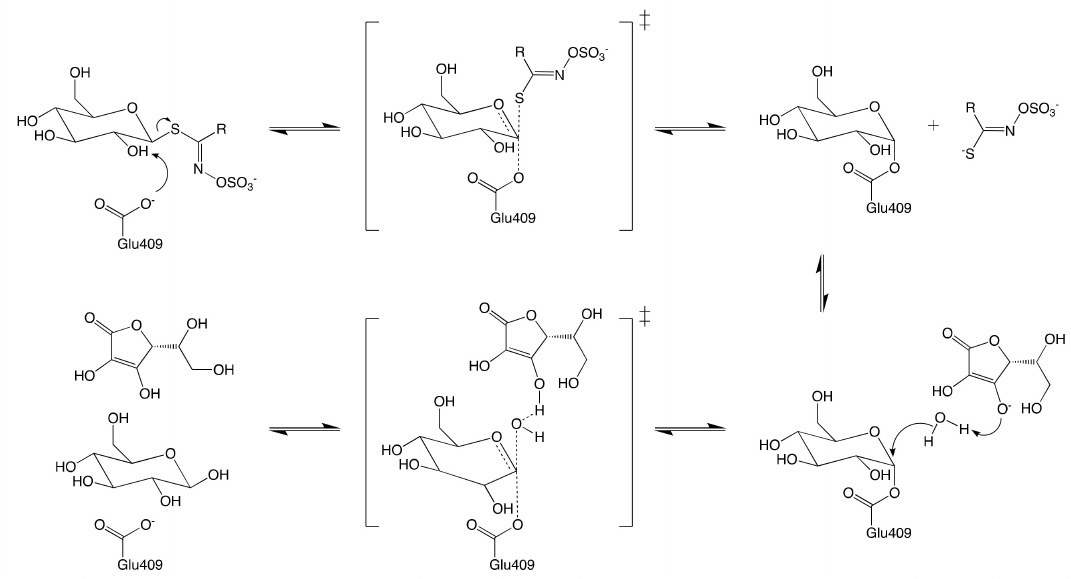
Figure 10. Schematic reaction mechanism of MYR in the presence of ascorbic